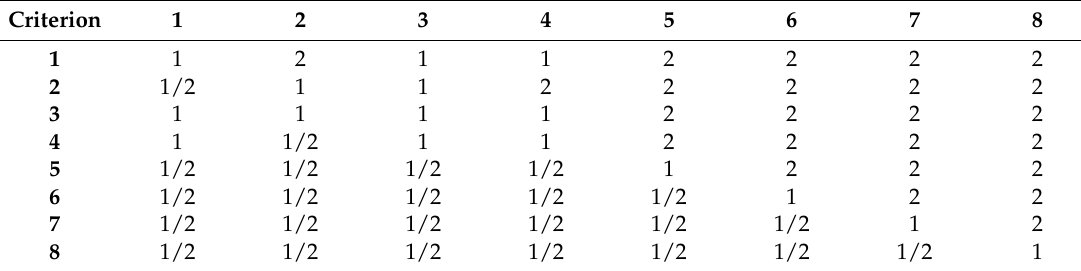
Table A5. Pairwise comparison for social